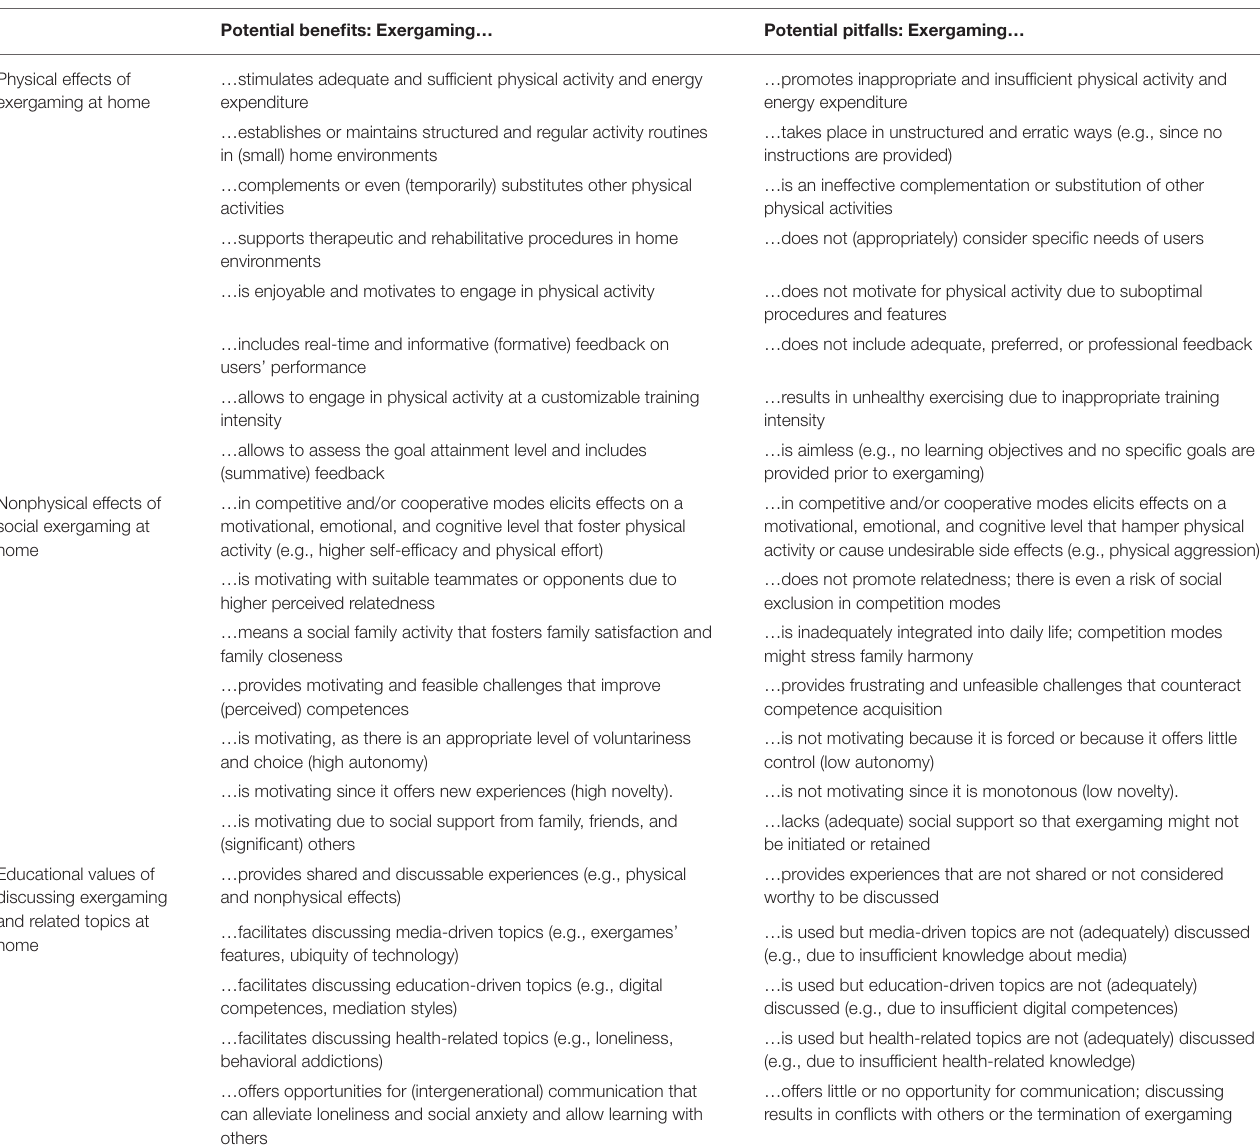
TABLE 1 | Potential benefits and pitfalls of educational and social exergaming at